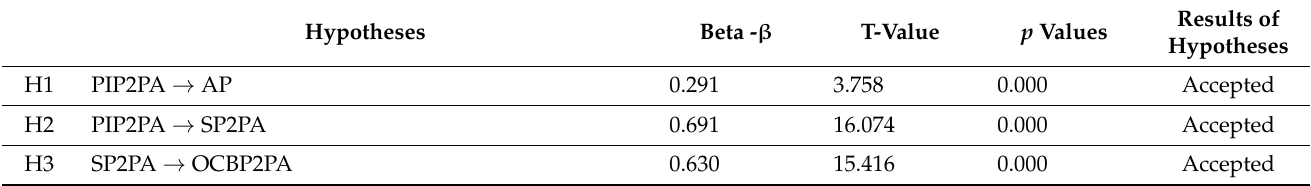
Table 5. The structural model’s